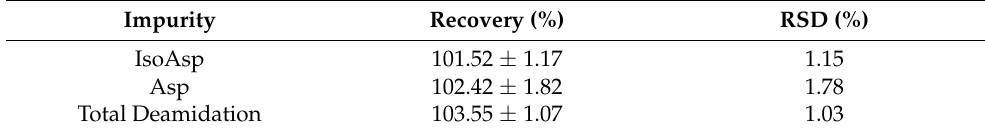
Table 4. Calculated recoveries a .